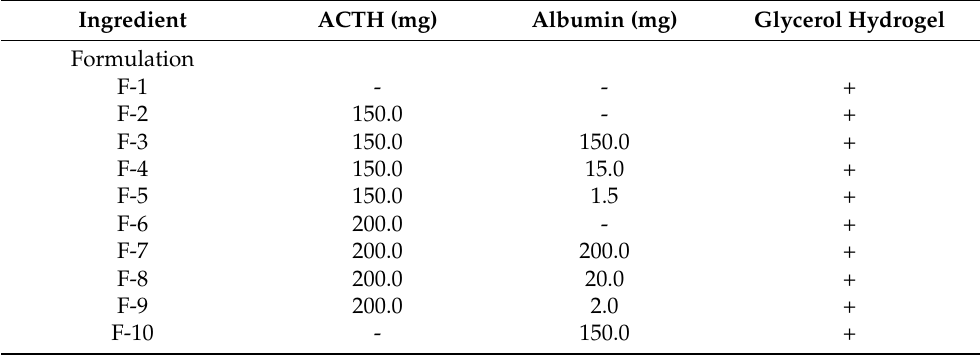
Table 1. Composition of prepared hydrogel formulations F-1–F-10 per 10 g of hydrogel.